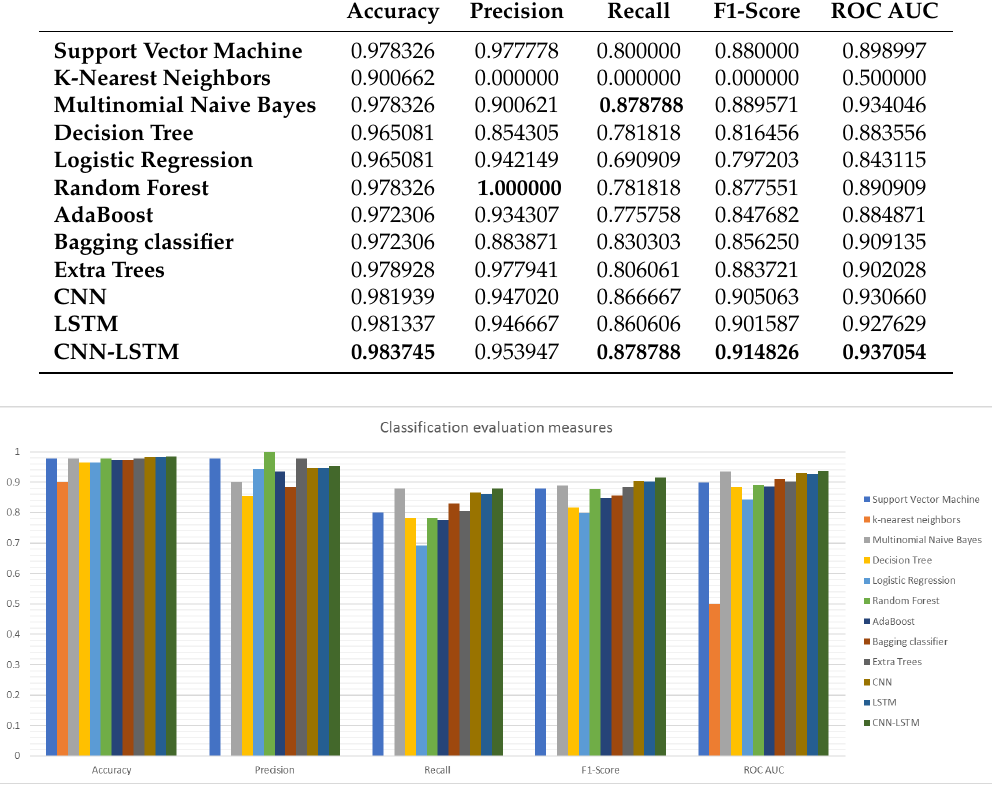
Figure 8. Comparison of the proposed CNN-LSTM model with other